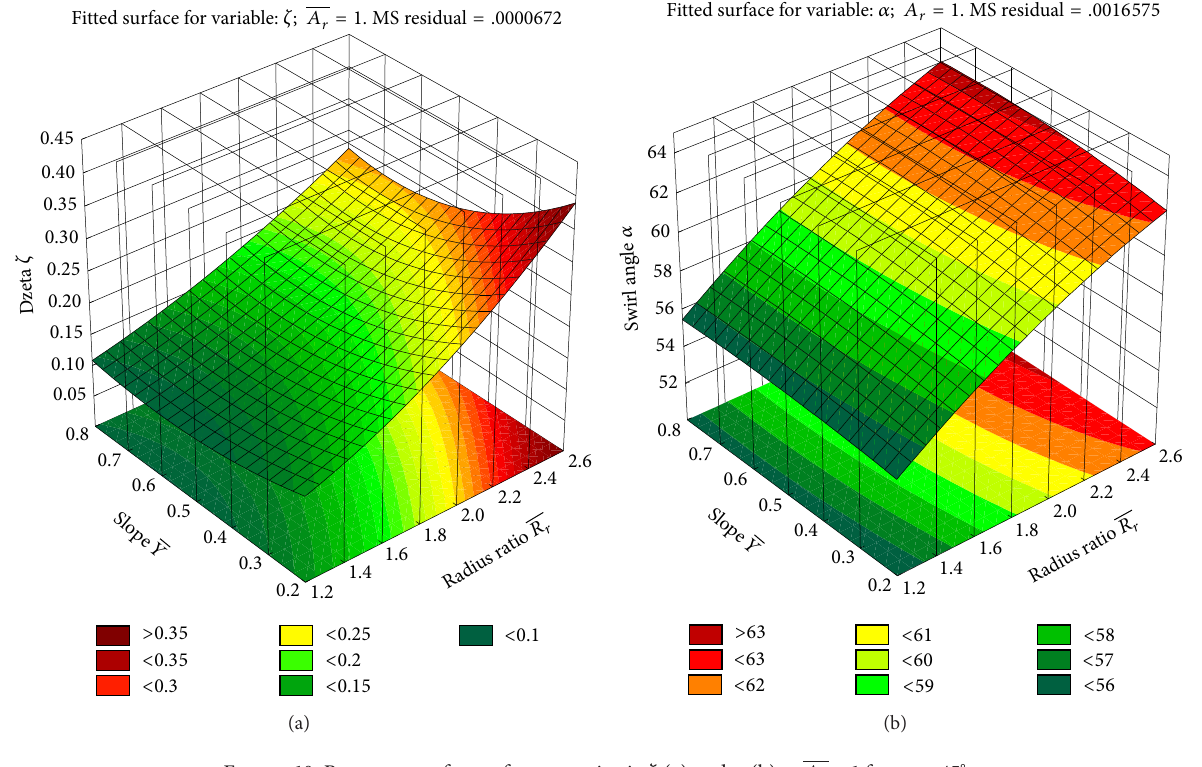
Figure 10: Response surfaces of output criteria 𝜁 (a) and 𝛼 (b) at 𝐴 𝑟 = 1 for 𝛼 0 = 45 ∘ .